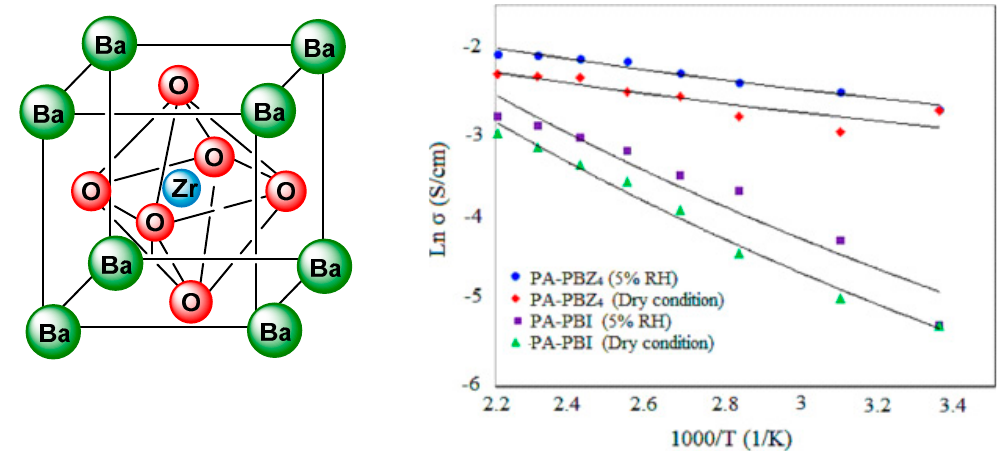
Figure 15. Structure of BaZrO 3 nanoparticles and Arrhenius plot of proton conductivity for PA-PBI and PA-PBZ 4 membranes, where Z 4 means the content of perovskite is 4 wt.%. Reproduced from [144] with permission of Elsevier.